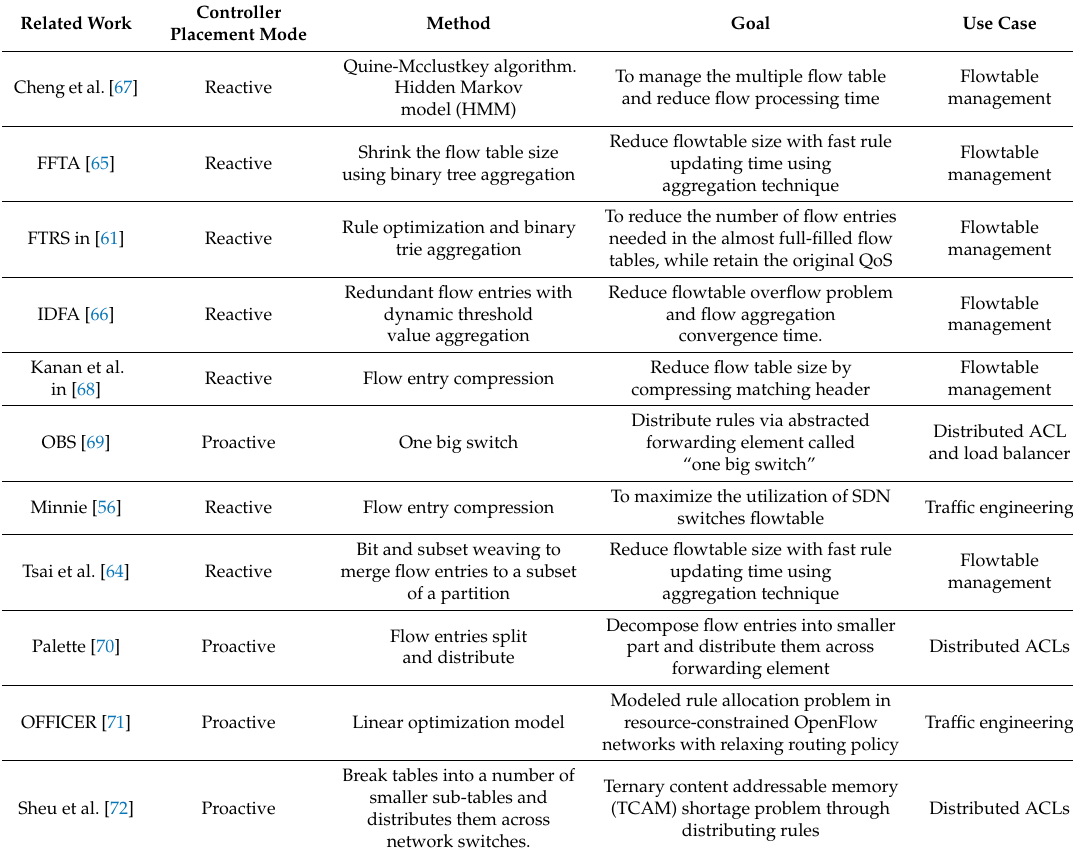
Table 3. Comparison of the related works of flow table entries reduction